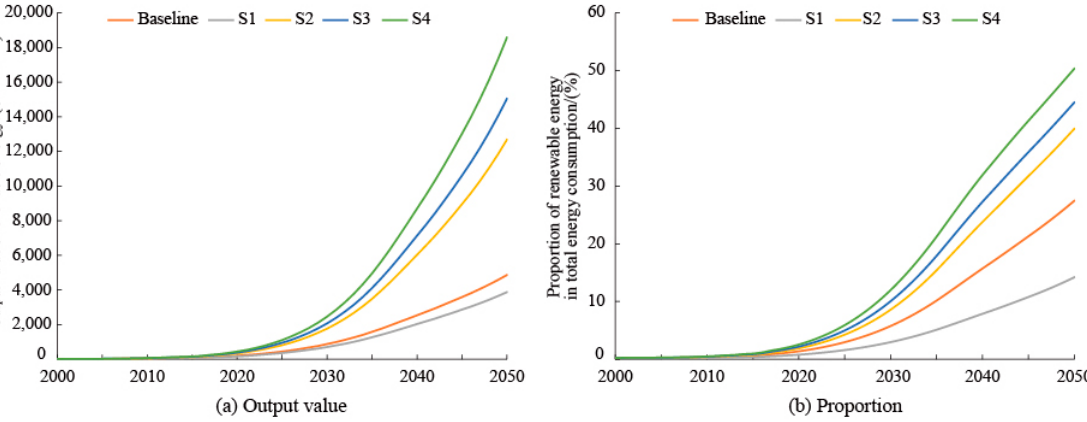
Figure 5. Simulation results of renewable energy output ( a ) and proportion ( b ) in S1, S2, S3, S4 and baseline scenario.